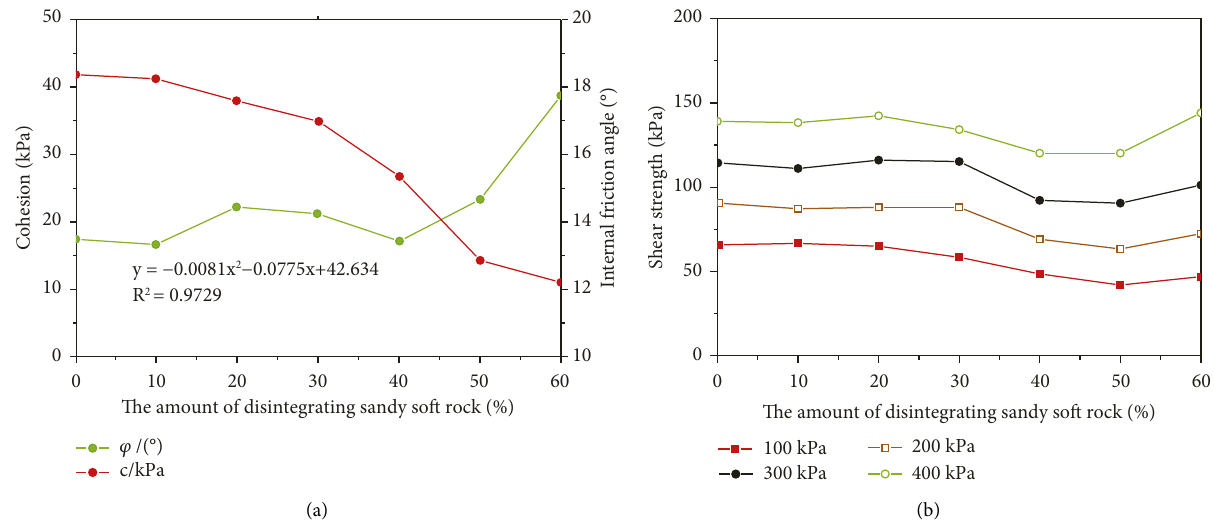
Figure 4: Relationship between the dosage and shear strength. (a) Shear strength parameters; (b) shear strength.